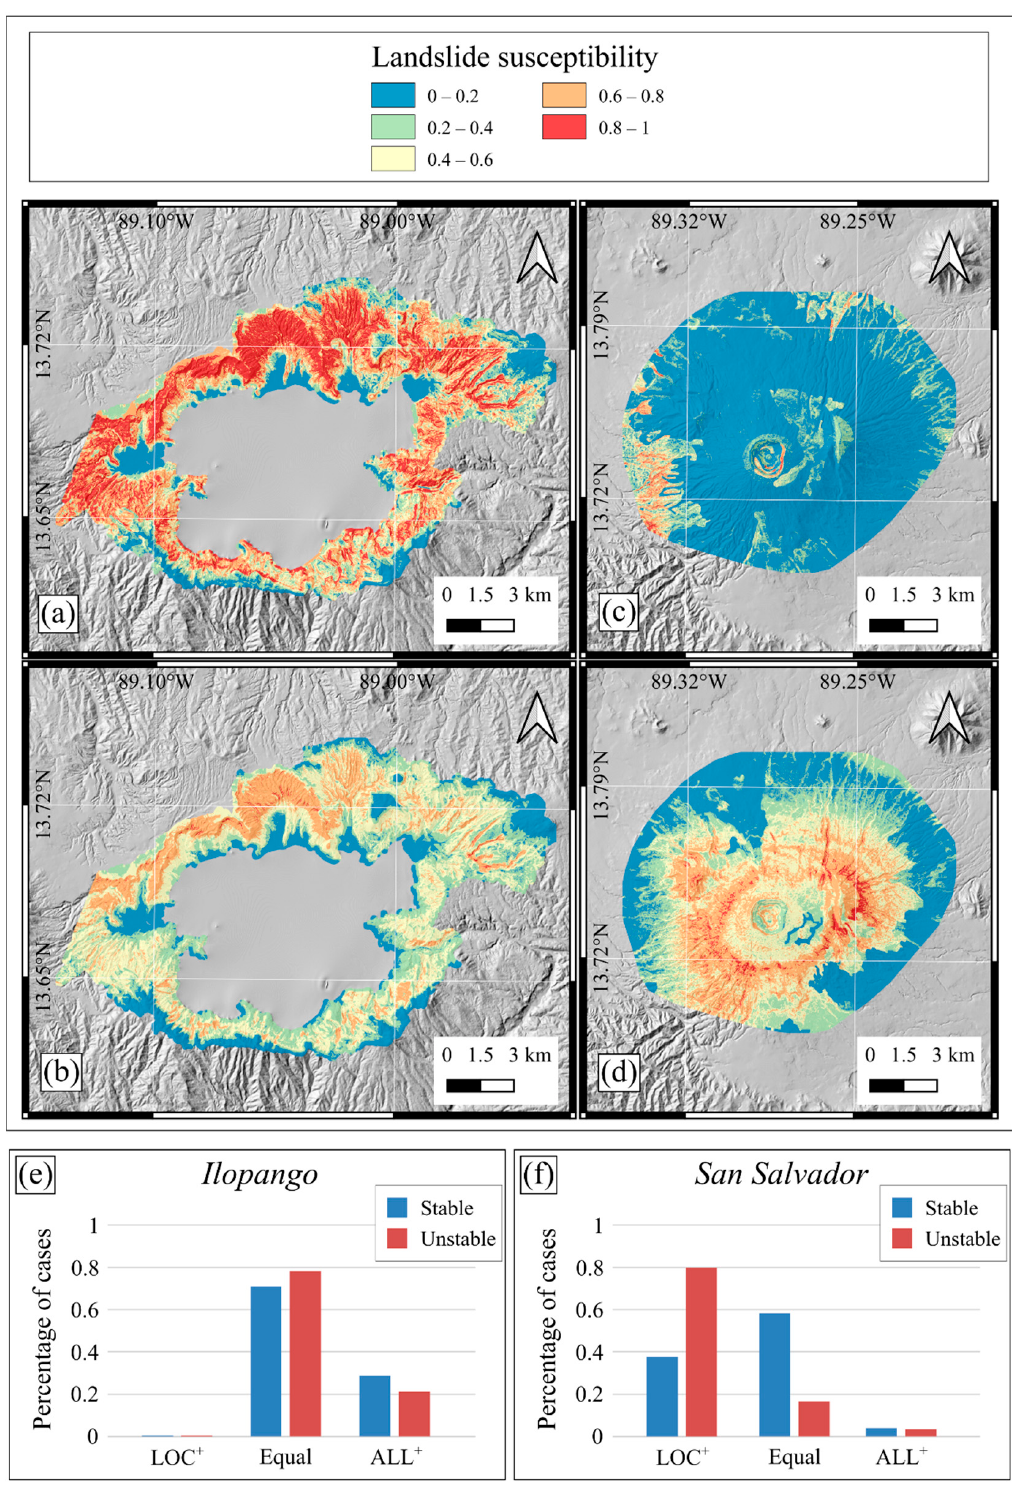
Figure 6. ALL ( a , c ) and LOC ( b , d ) landslide susceptibility maps for Ilopango (on the right side) and San Salvador (on the left side) sectors. The histograms ( e , f ) show the percentage of observed (stable/unstable) cases, when (i) LOC model assigns a higher susceptibility with respect to the ALL model (LOC + ), (ii) both the models assign the same predicted status (Equal) or (iii) the ALL model sets higher susceptibility with respect to the LOC model (ALL + ).